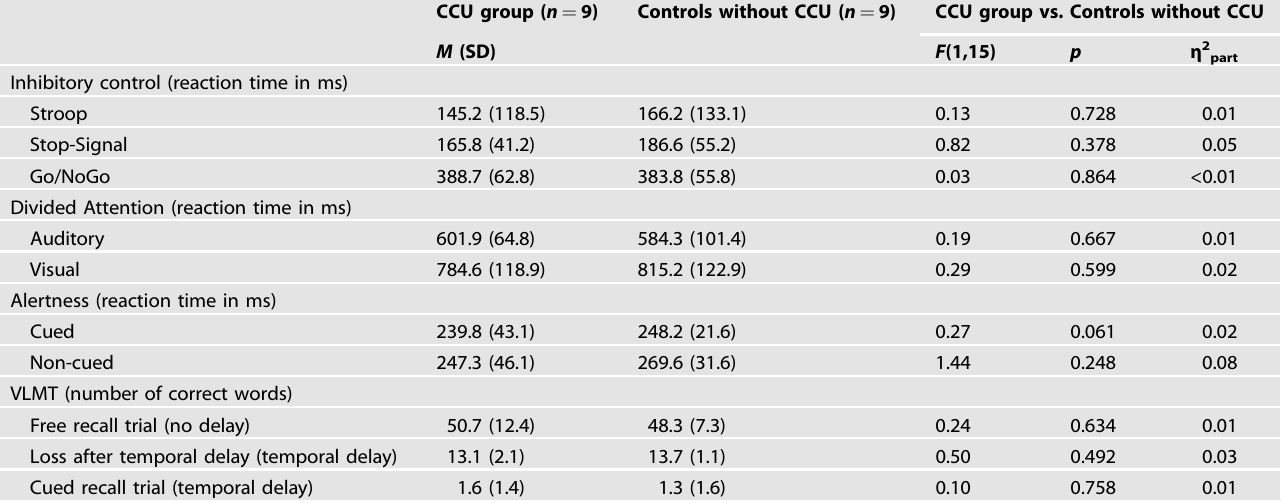
Table 3. Characteristics of cognitive performance of the